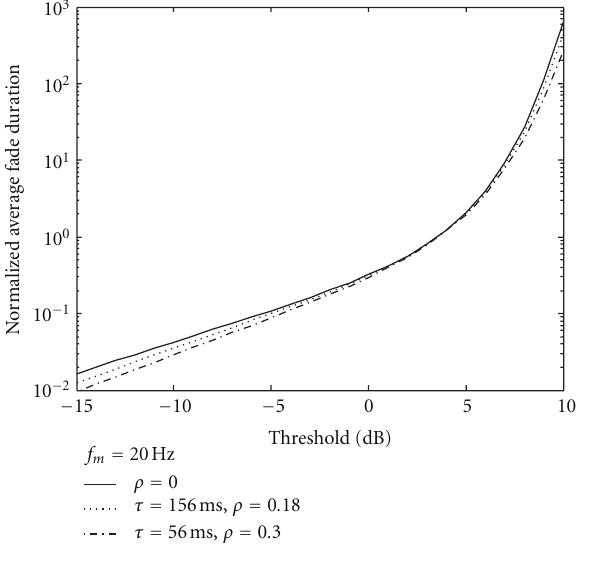
Figure 5: Normalized AFD for σ 2 1 = σ 2 2 =